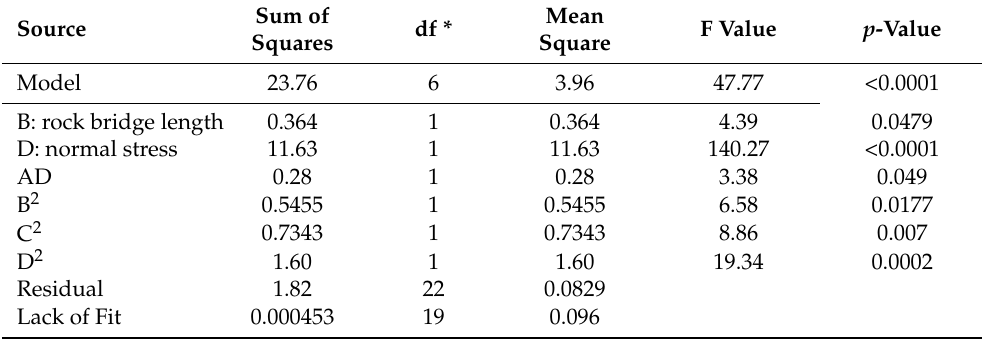
Table 7. ANOVA for response surface quadratic model for shear strength.